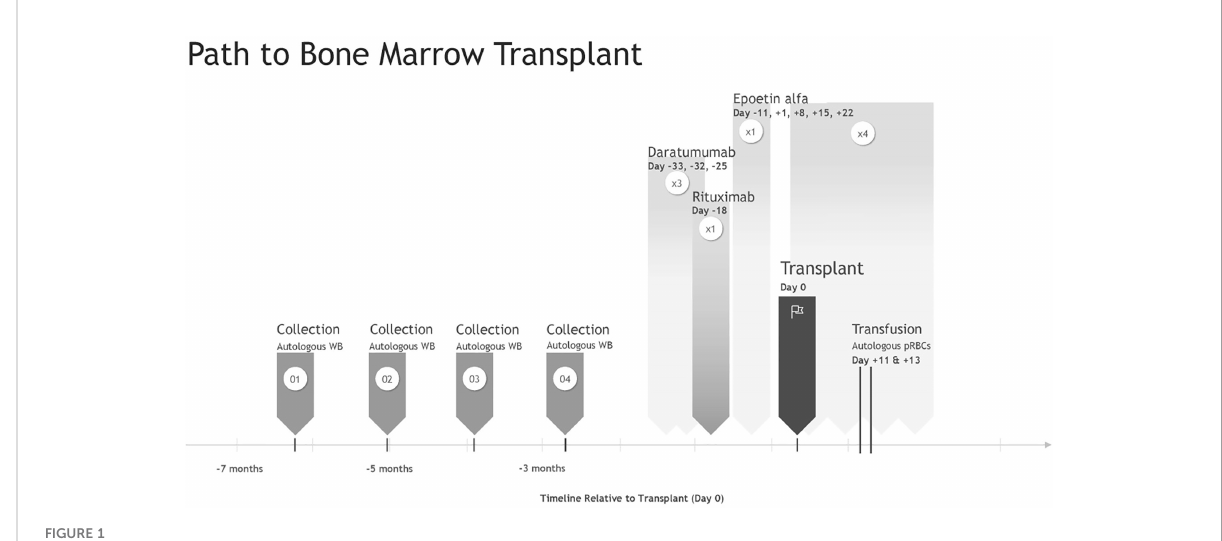
FIGURE 1 Patient pre and post transplant timeline relative to Day 0.